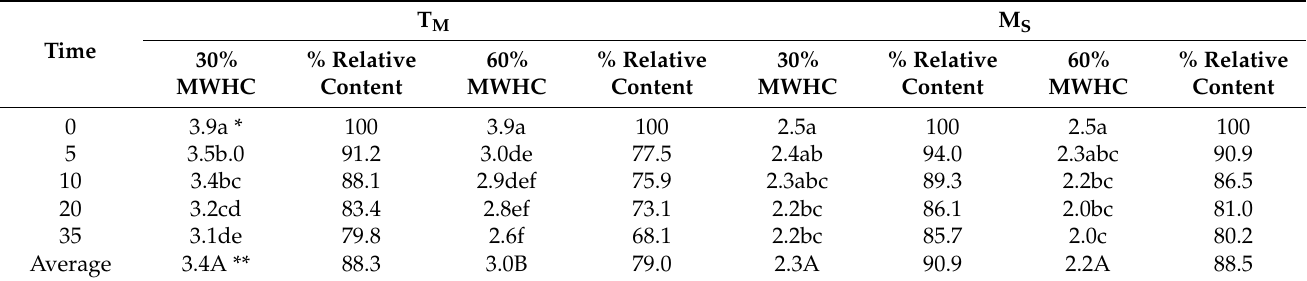
Table 4. Effect of incubation time and soil moisture on a release rate of total nitrogen from organic fertilizers (%N in dry mass).